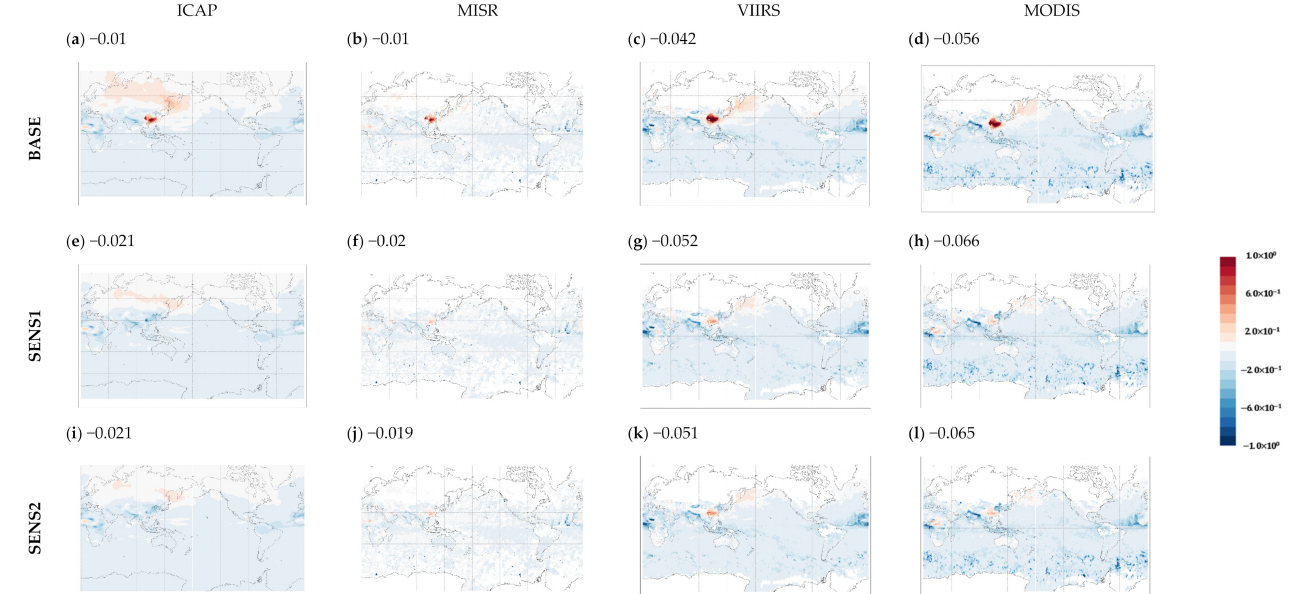
Figure A1. Global distribution of the differences in GEFS AOD ( BASE ( a – d ), SENS1 ( e – h ) and SENS2 ( i–l )) from ensemble simulation of ICAP ( a , e , i ), and satellite observations of MISR ( b , f , j ), VIIRS ( c , g , k ), and MODIS ( d , h , l ) in JJA 2021 (the numbers above figures indicate the global mean